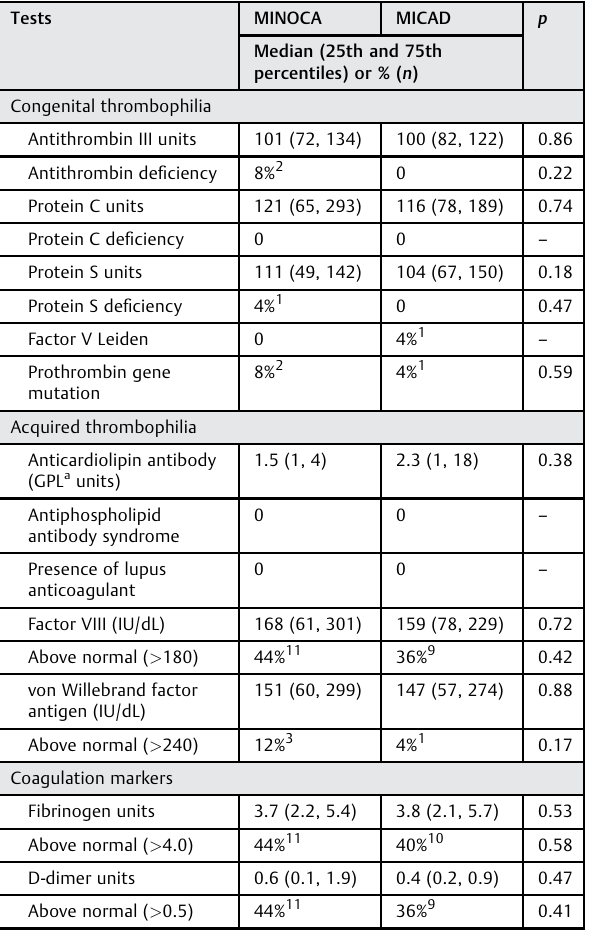
Table 3 Incidence and expression of thrombophilia